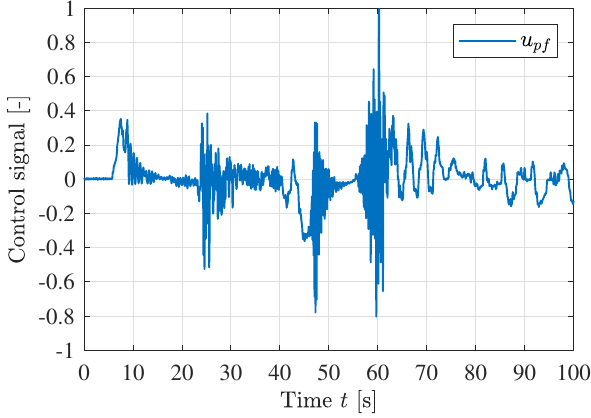
Figure 27: Control signal from pressure feedback.